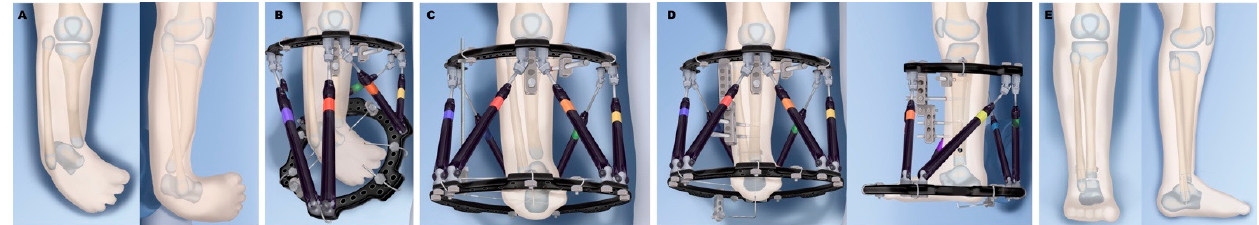
Figure 6. Treatment of Paley type 3A. ( A ) Distal tibia-fibula diastasis. The tibial plafond is absent and the end of the tibia